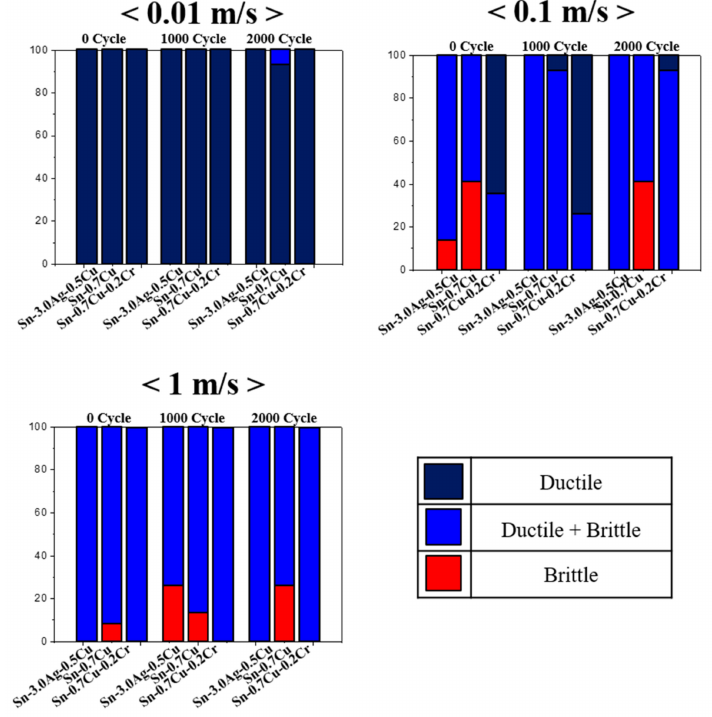
Figure 8. Statistics of fracture mode of solder joins under various shear